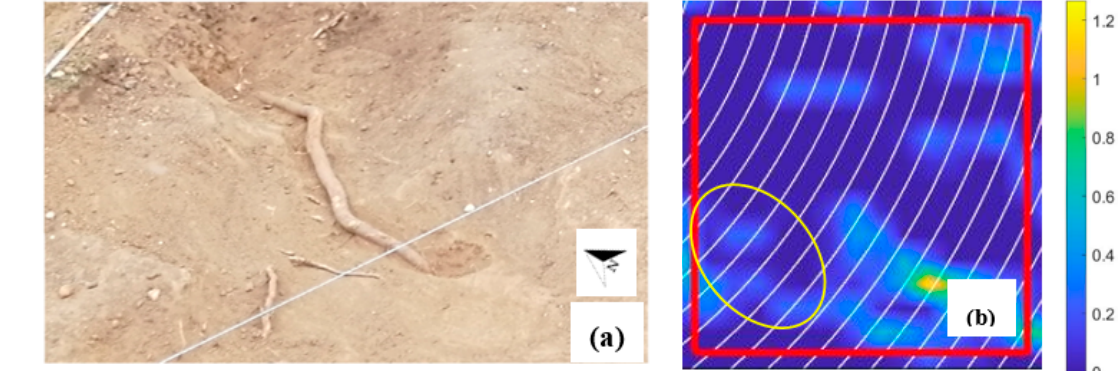
Figure 21. The excavated root at the bottom-left corner of the excavated area, ( a ) development of the root, and ( b ) a close-up view of the 0.20–0.30 m density map. The yellow circle highlights an area with an increased density, corresponding to the excavated root.